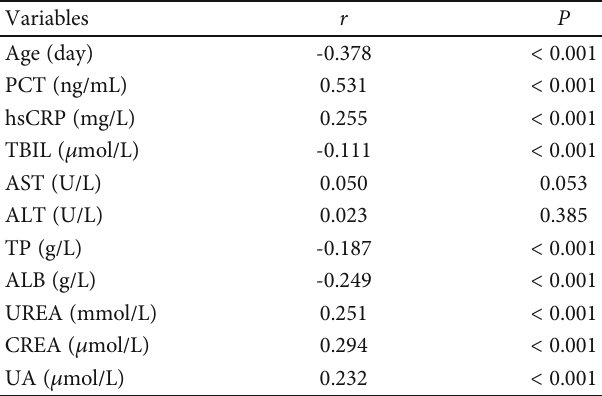
Table 3: Correlations between NLR and clinical